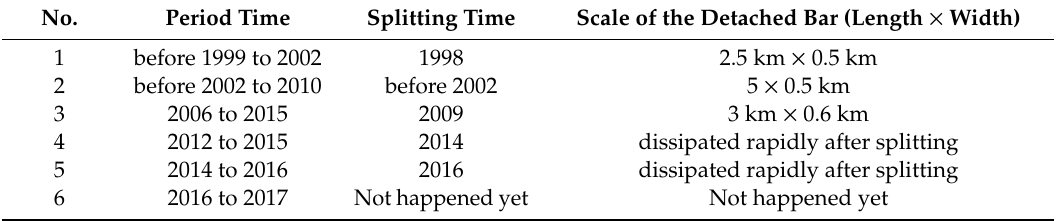
Figure 3. Nine out of 17 of the digital elevation models (DEMs) based on the bathymetric measurements showing the six evolution cycles with overlapping of time, in which ( a ) to ( b ) show 1st cycle, ( b ) to ( e ) show 2nd cycle, ( d ) to ( g ) show 3rd cycle, ( f ) to ( g ) show 4th cycle, ( g ) to ( h ) show 5th cycle, and ( h ) to ( i ) shows 6th cycle. Table 2. Periodic change and splitting events of the JJS from 1999 to 2017. No. Period Time Splitting Time Scale of the Detached Bar (Length ×